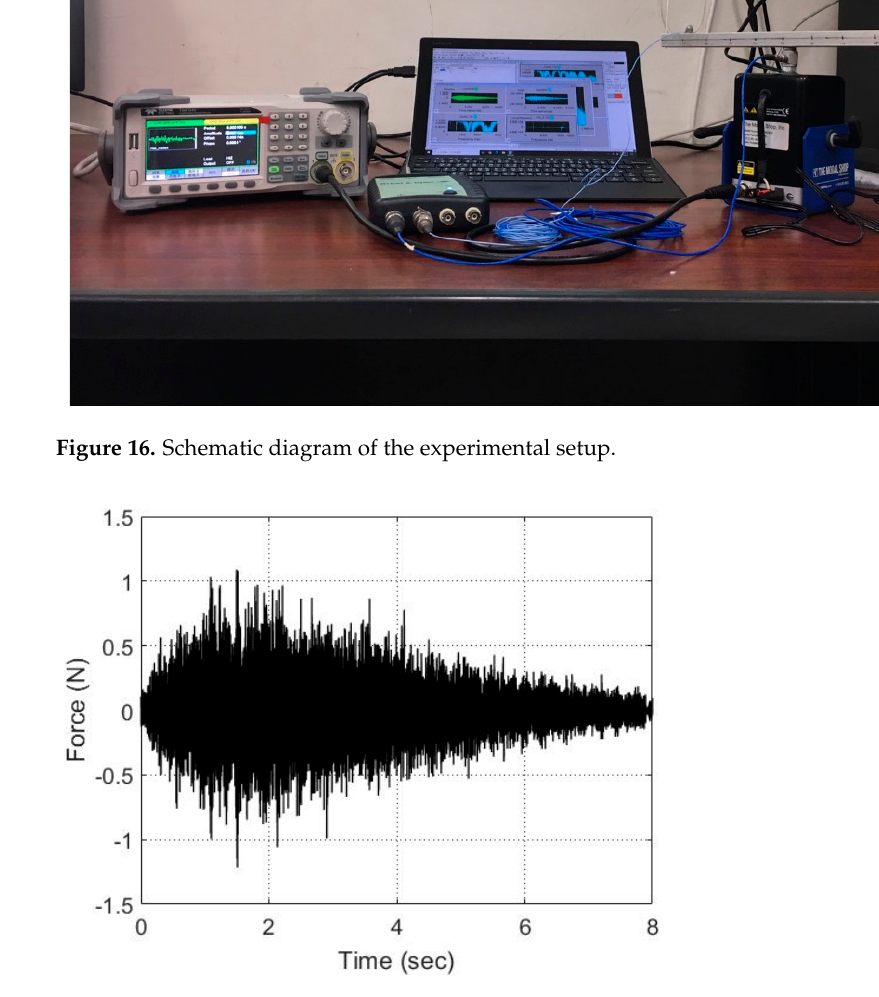
Figure 17. Excitation signal (force gauge).